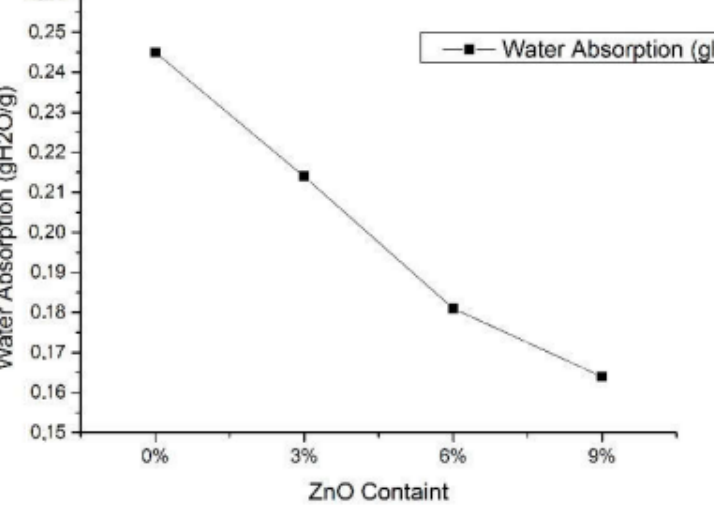
Figure 8. Water absorption result of biofoam with different ZnO addition [173].